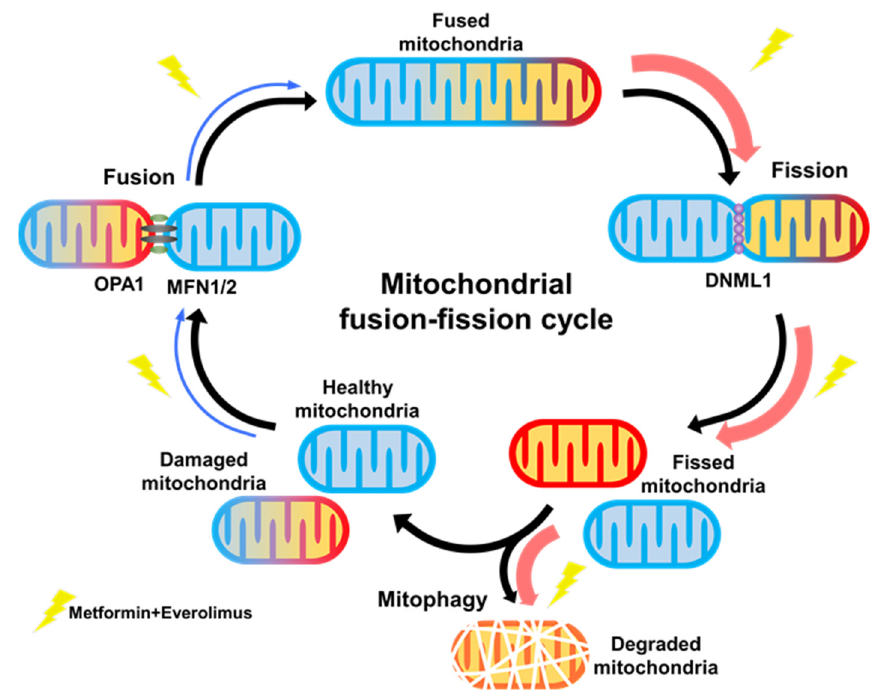
Figure 6. Graphical abstract.